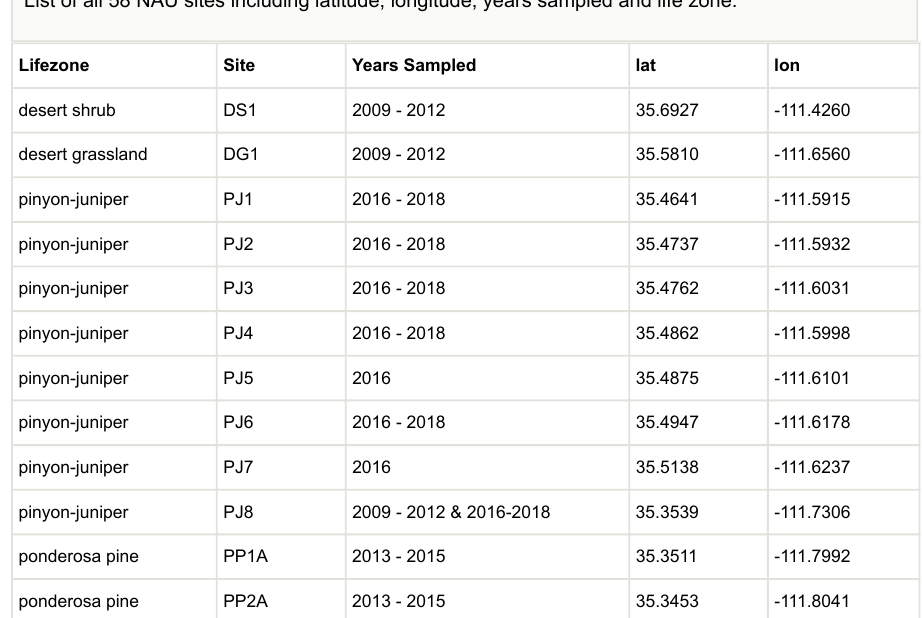
List of all 58 NAU sites including latitude, longitude, years sampled and life